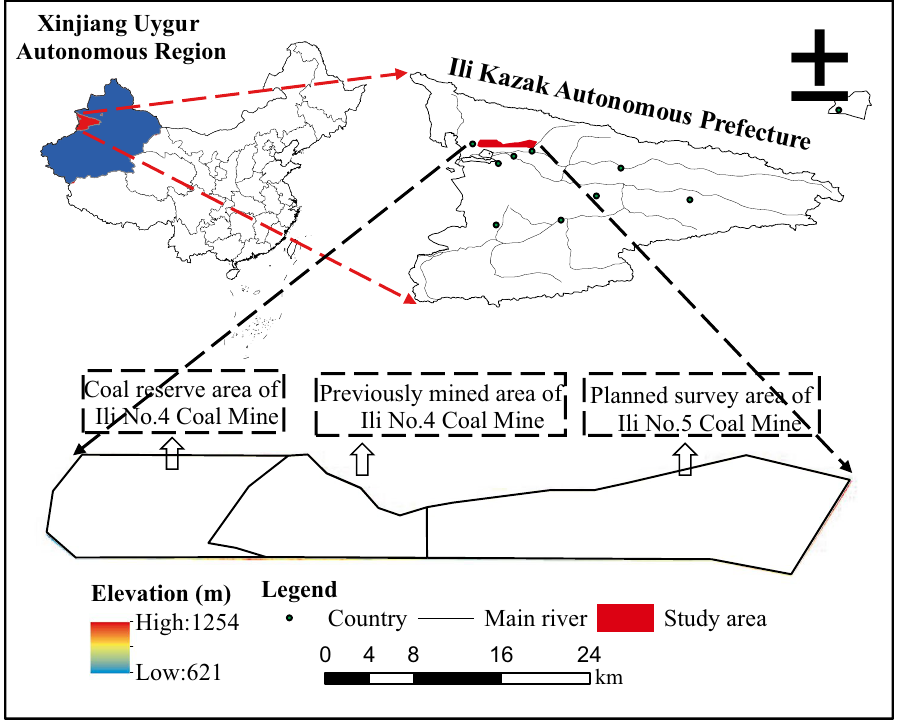
Figure 1. Location and elevation of the study area. The Figure is created using ArcGIS ver.10.2 (https:// www. esri.